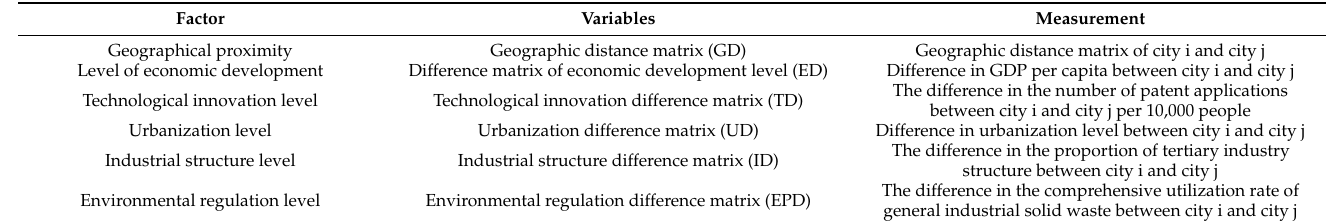
Table 1. Spatial correlation